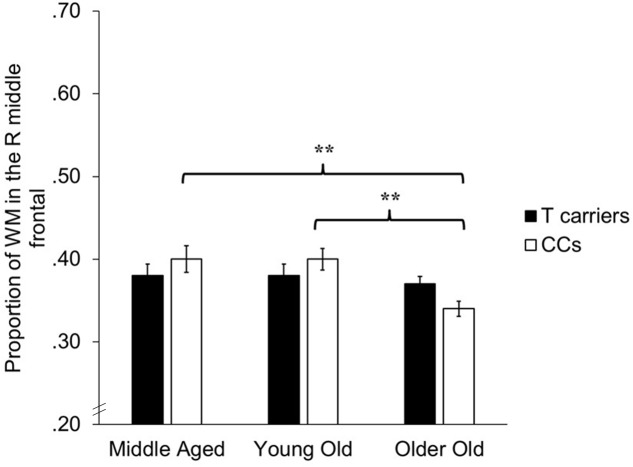
Bar graph depicting average proportion of white matter in the right middle frontal gyrus for T carriers and CC homozygotes across the three age groups. ∗∗p < 0.001, k > 50.